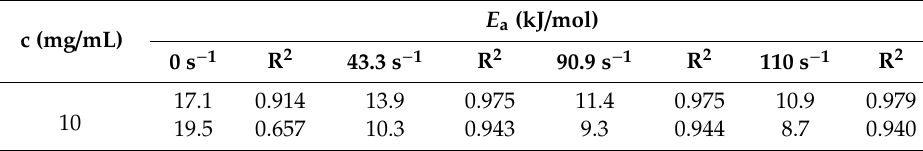
Table 2. E a value for collagen solution at di ff erent shear